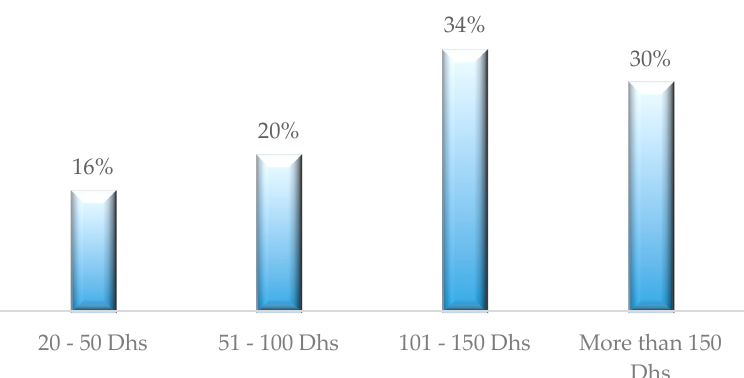
Figure 2. The Amount of Purchase where Exchange Rate is 1 USD = 3.65 Dirhams Spent in the Latest Food Order Respondents Posted Online.